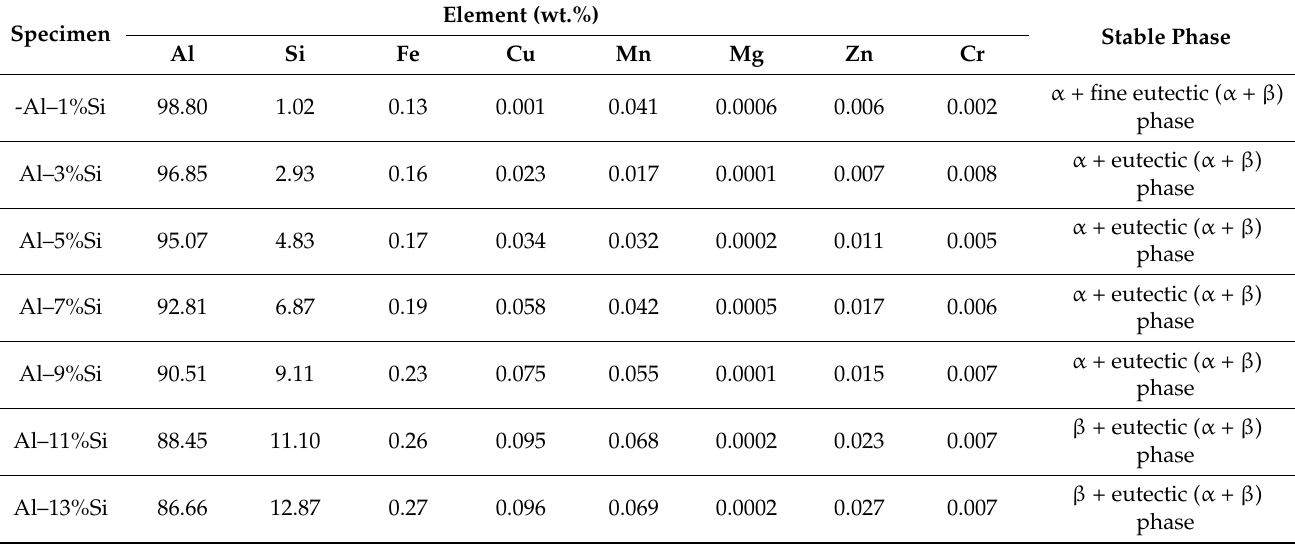
Table 1. The chemical composition of the alloys was determined with emission